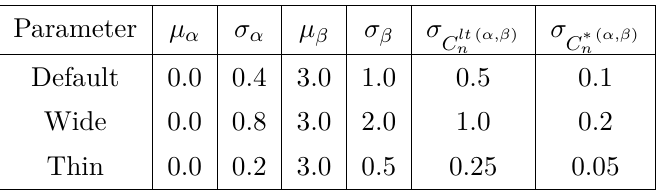
Table 2 . Parameters of each Bayesian prior distribution used in the maximum likelihood fits to (cid:0) (cid:1) the reduced pseudo-ITD Y ν, z 2 data. Default corresponds to fits with prior widths based on reasonable physical intuition, while Wide ( Thin ) represent an increase (decrease) of each prior width by a factor of two. The latter two cases are discussed in appendix A and offer a window into the sensitivity of our conclusions on the imposed prior distributions. The prior width of each expansion coefficient parameterizing the leading-twist component of Y while σ ∗ ( α,β ) C